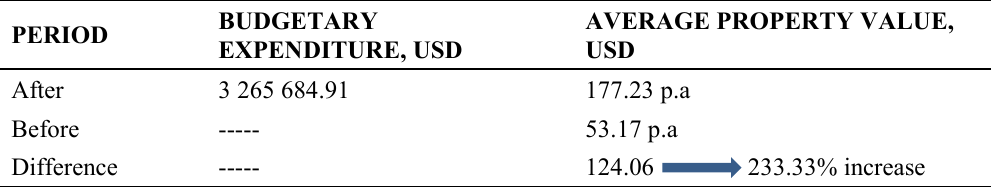
Table 1. Average Property Values before and after Road Construction BUDGETARY AVERAGE PROPERTY VALUE, PERIOD EXPENDITURE, USD USD After 3 265 684.91 177.23 p.a ----- 53.17 p.a Difference ----- 124.06 233.33%